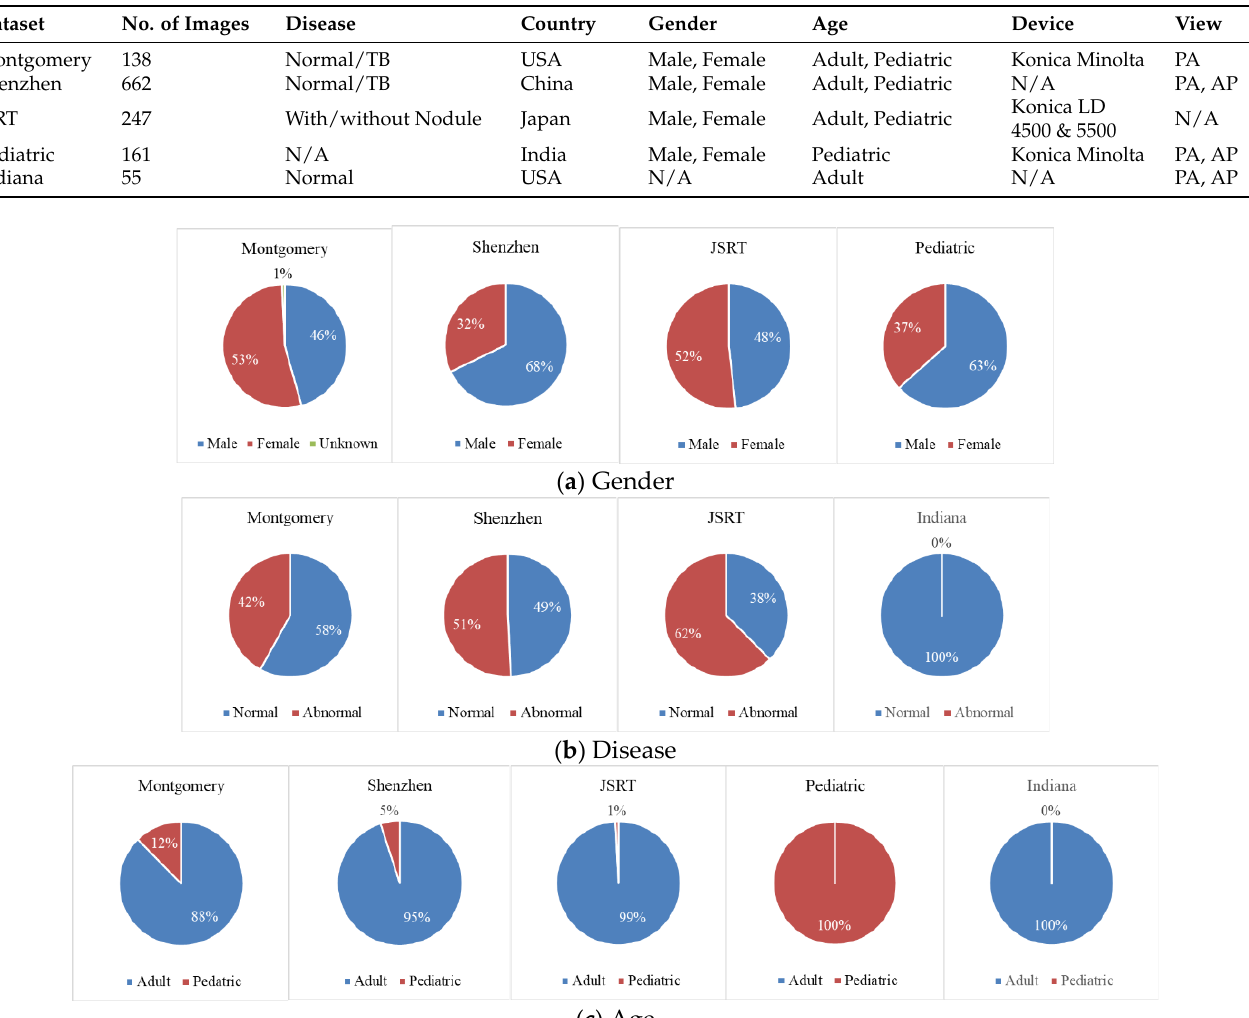
Table 1. Comparison of datasets.